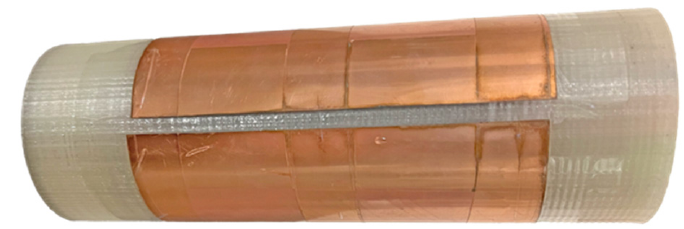
Figure 5. Fabricated capacitance-based concave sensor.